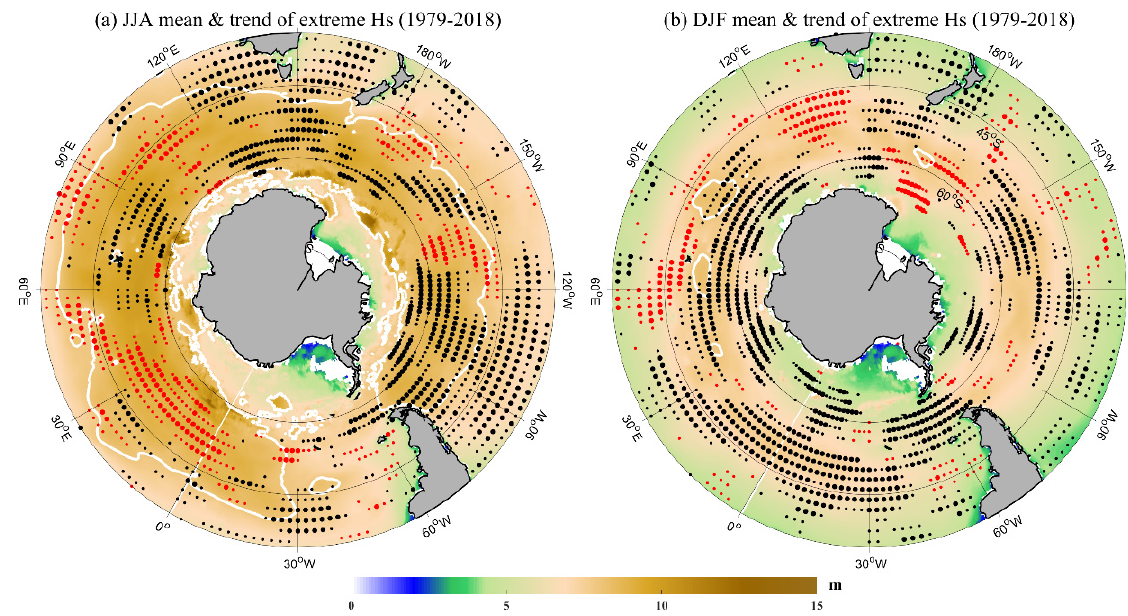
Figure 3. Similar to Figure 2, but for the EWH. The white contour is the 8 m isoline. The small black dots indicate the trend is higher than 0.01 m/a and less than 0.02 m/a, the larger black dots indicate the trend is larger than 0.02 m/a, and the red dots indicate a decreasing trend with the criteria similar to those of the black dots.